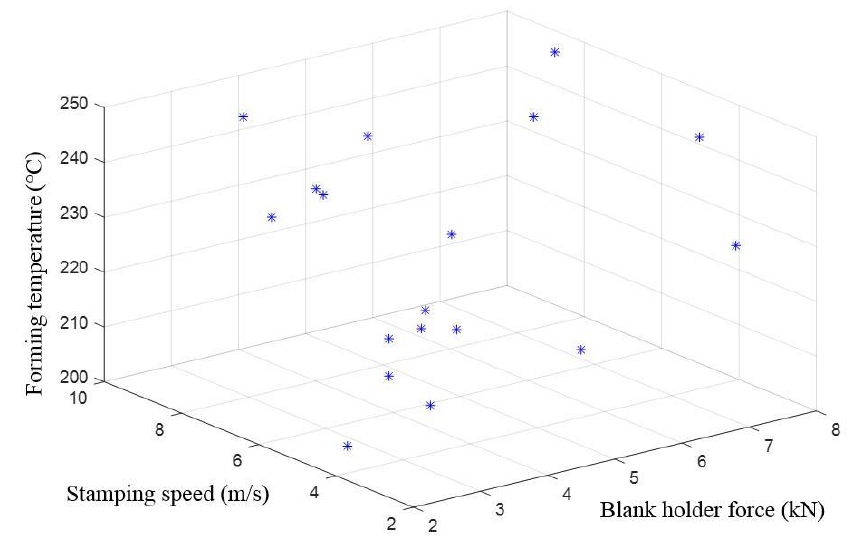
Figure 5. Sample distribution of LHD in the range of each process parameter.